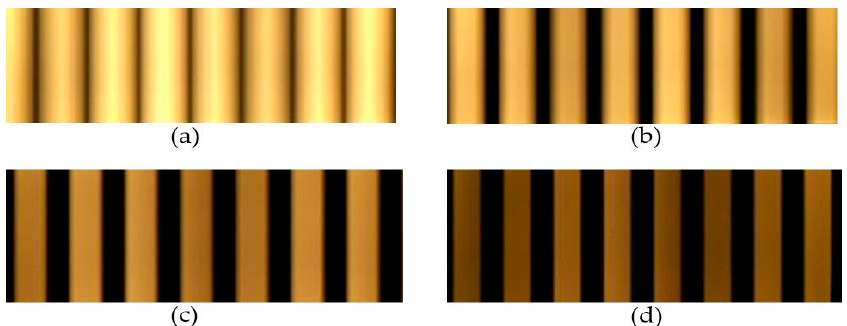
Figure 12. Rolling image sensor operation.